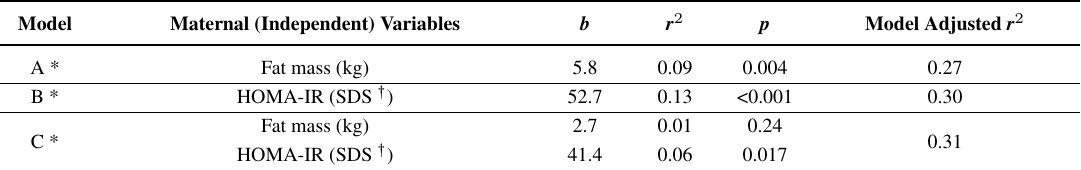
Table 3. Fat mass of one-week-old girls regressed on fat mass and HOMA-IR of their mothers when pregnant in gestational week 32. (Slope of regression line ( b ) and coefficient of determination ( r 2 ), calculated from r